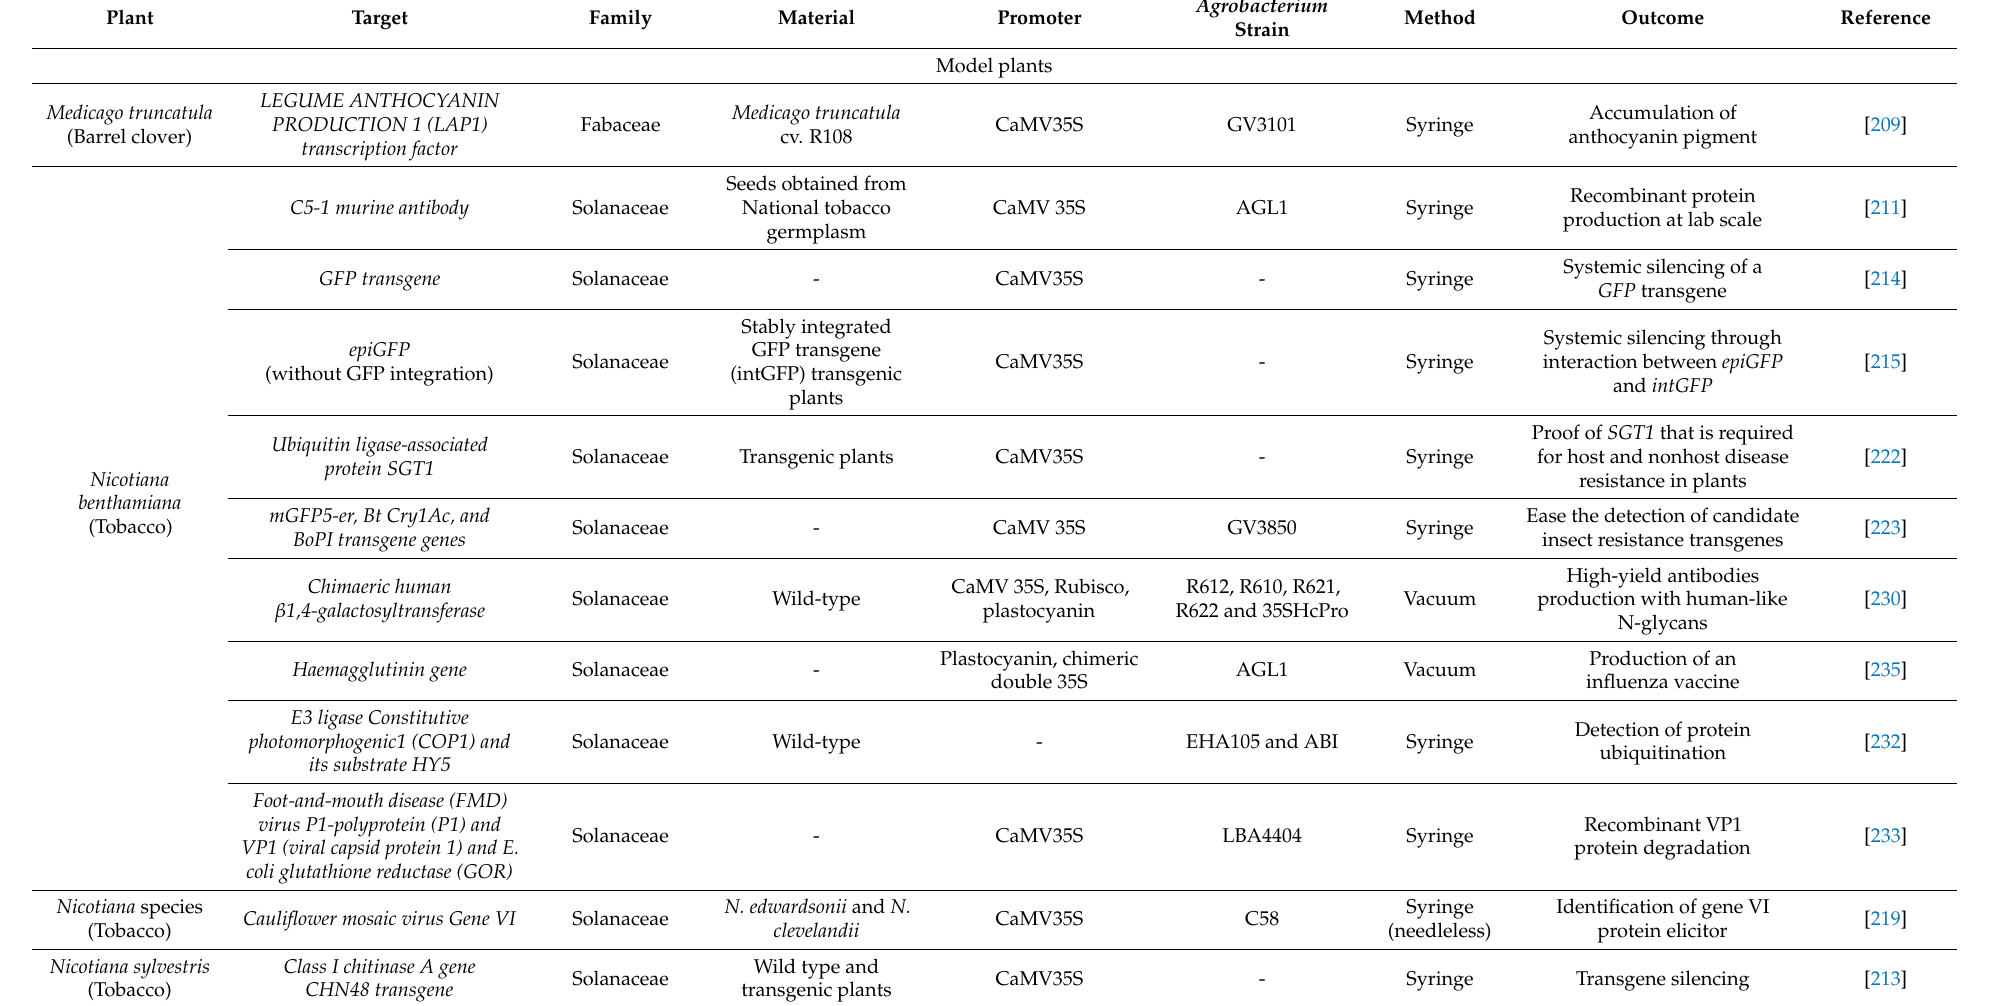
Table 3. Application of agroinfiltration in plants other than genome editing after the discovery of transient expression by Kapila et al.